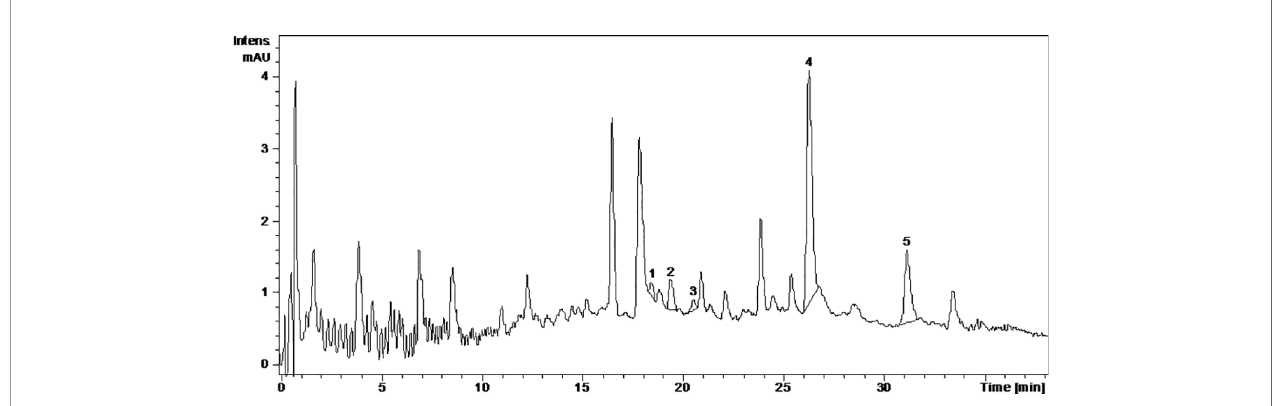
FIGURE 4 | The UV chromatogram offermented Feteasca ̆ neagra ̆ 2015 grape pomace extract. 1, Hyperoside; 2, Isoquercitrin; 3, Miricetol; 4, Quercetin; 5,